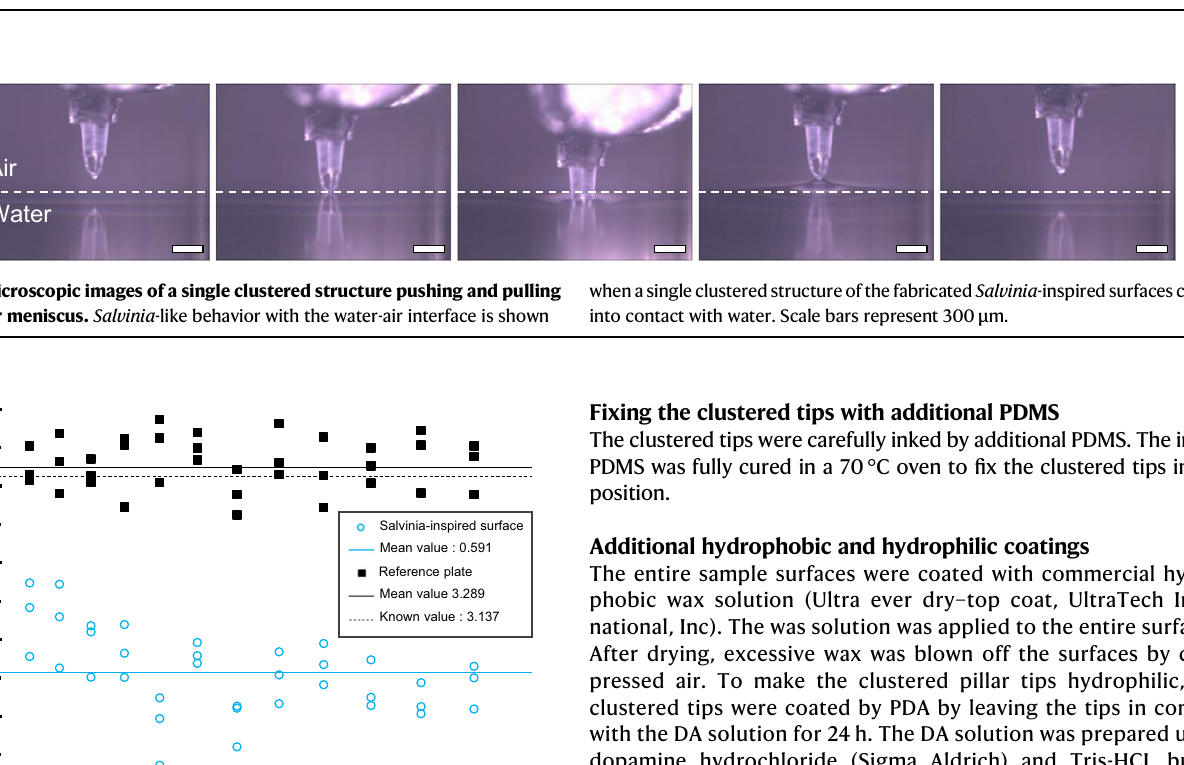
Fig. 5 | SEM images of the fabricated sample surface. a Clustered hierarchical pillar arrays. b Hydrophobic wax and hydrophilic tips on a single clustered structure.